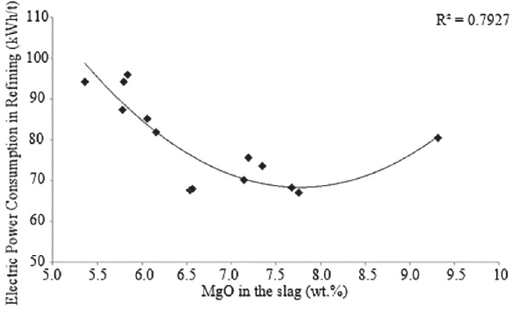
Figure 5: MgO content and electric power